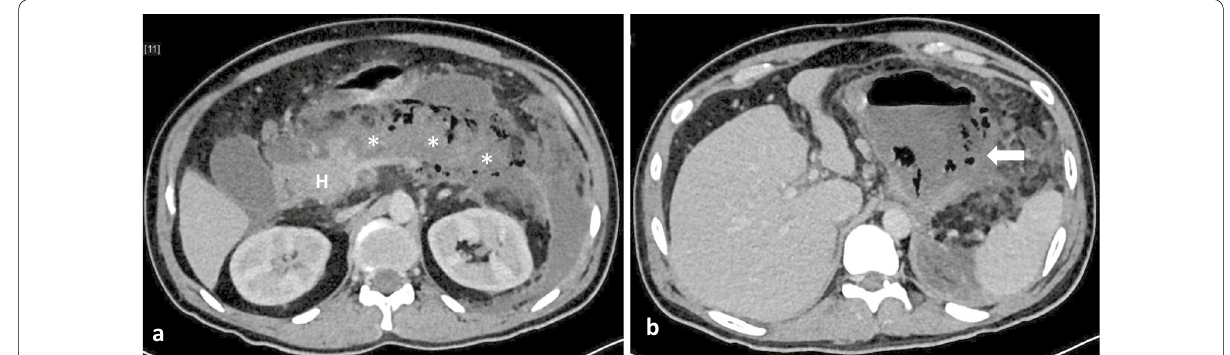
Fig. 1 CECT axial image a showing necrotizing pancreatitis (asterisk) with acute necrotic collections in peripancreatic, left anterior pararenal, and paracolic gutter; head of the pancreas (H) is relatively spared. b Defect in the stomach wall (white arrow)